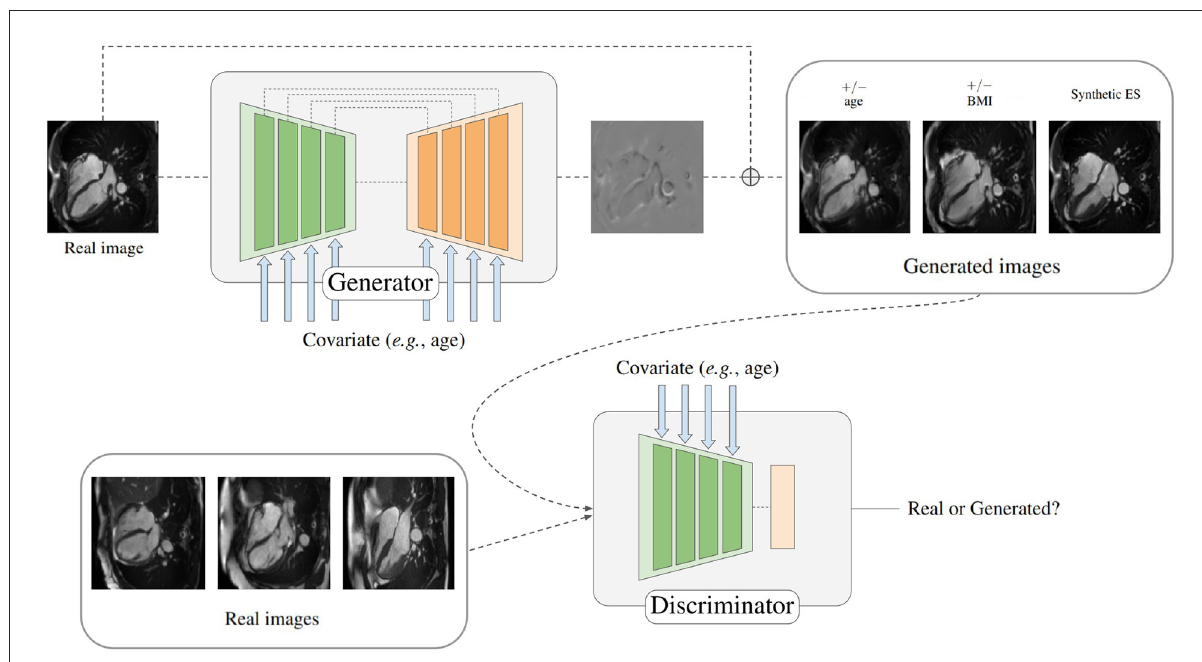
FIGURE1 Depiction of the proposed model for generating synthetically aged and rejuvenated heart images. The covariate is combined with the model features by using conditional biasing. Heart scans reproduced by kind permission of UK Biobank ©